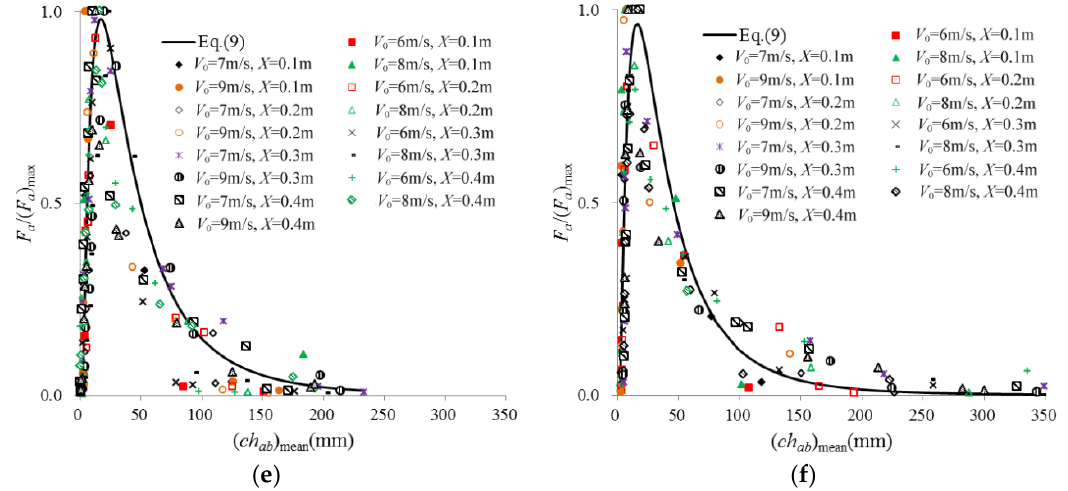
Figure 14. Dimensionless bubble frequency as a function of the bubble chord length compared with the theoretical curve derived from Equation (9). Upper nappe ( a ) ( h , b ) = (4.5 cm, 4.5 cm), θ = 10%. ( b ) ( h , b ) = (6.5 cm, 6.5 cm), θ = 10%; lower nappe ( c ) ( h , b ) = (4.5 cm, 4.5 cm), θ = 10%. ( d ) ( h , b ) = (6.5 cm, 6.5 cm), θ = 10%; side nappe ( e ) ( h , b ) = (4.5 cm, 4.5 cm), θ = 10%. ( f ) ( h , b ) = (6.5 cm, 6.5 cm), θ =